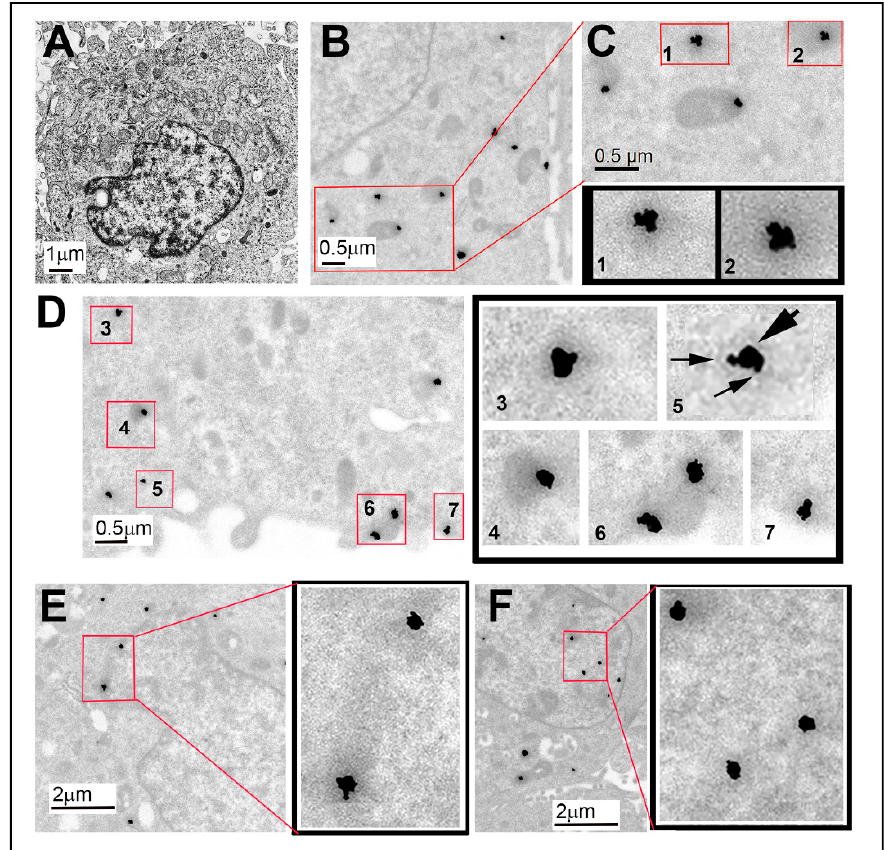
Figure 3. EM immunodetection of Sig1R and NRF2 in cultured 661 W photoreceptor cells. The 661 W cells cultured as described in the text were processed for post-embedding EM immunolocalization to detect Sig1R and NRF2 using nanogold-labeled secondary antibodies. ( A ) Low-magnification image of a typical cell shown adjacent to higher magnification images of the cytoplasm ( B – D ) and the nucleus ( E , F ). ( B ) An area encased in red, which is magnified in ( C ); wo clusters are shown at even higher magnification (panels C1,C2 ). The clusters are gold particles reflecting the two proteins of interest (NRF2 (large, electron-dense gold nanoparticles) and Sig1R (smaller, electron-dense gold nanoparticles)). ( D ) Five clusters (numbered D3, D4, D5, D6, D7 ) are shown at higher magnification in the adjacent panel. ( E ) An area of the nuclear membrane; two clusters are outlined in red, which are enlarged in the adjacent panel (outlined in black) ( F ) Clusters within the nucleus outlined in red and enlarged in the adjacent panel. The data reflect co-localization of NRF2 and